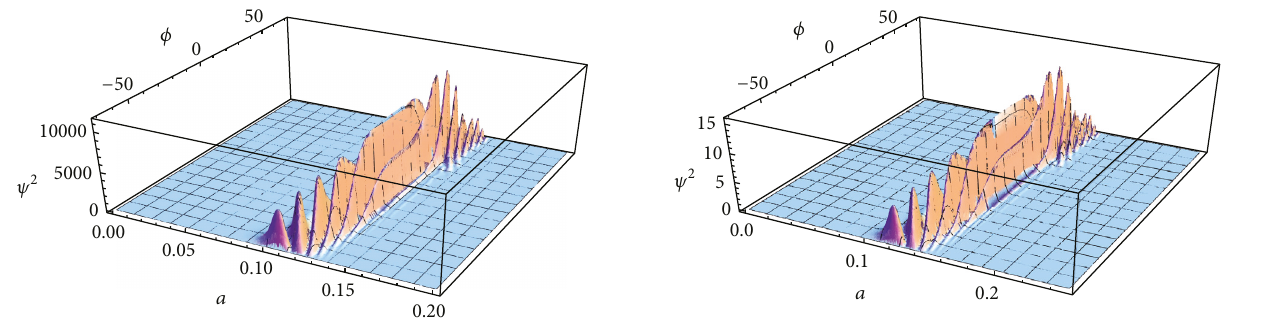
Figure 4: Numerical profile of 𝜓(𝑎,𝜙) with initial conditions: Figure 3: Numerical profile of 𝜓(𝑎,𝜙) with initial conditions: 𝜓(0,𝜙) = 0 and 𝜓(𝑎,𝜙 ) = 𝑓(𝑎) , where 𝜙 0 0 defines half the width 𝜓(0,𝜙) = 0 and 𝜓(𝑎,𝜙 ) = 𝑓(𝑎) , where 𝜙 0 0 defines half the width of our solution domain over 𝜙 . Here, we have set ℏ = 1 , 𝛽 = −100 , of our solution domain over 𝜙 . Here, we have set ℏ = 1 , 𝛽 = −200 , and 𝑘 = 0 and 𝑘 = 0 .